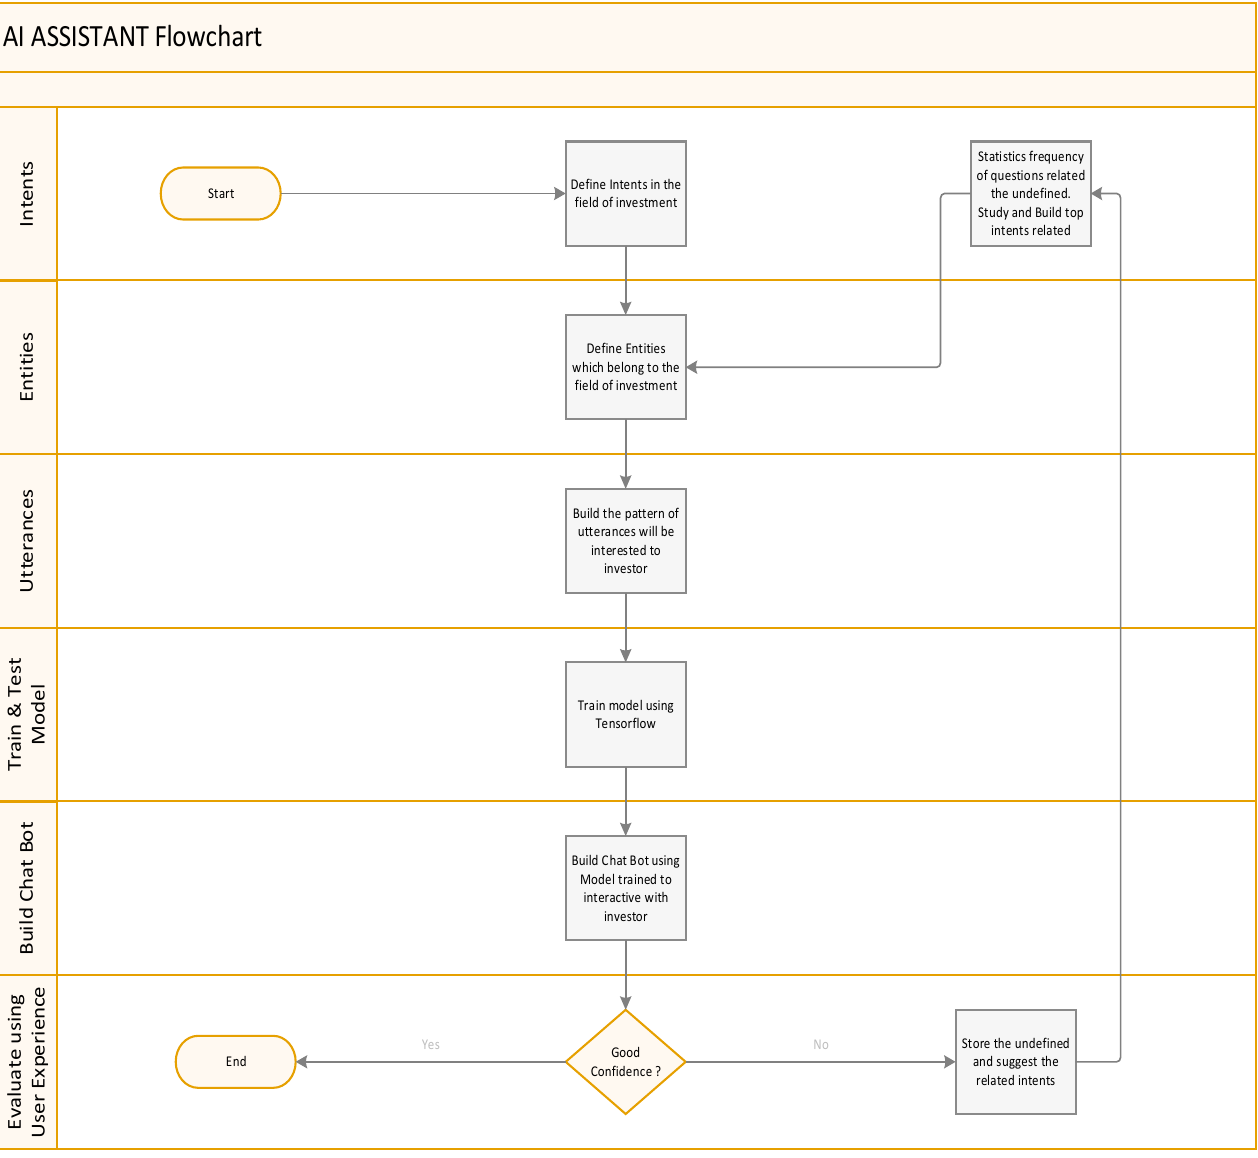
Figure 5. AI Assistant’s main workflow.